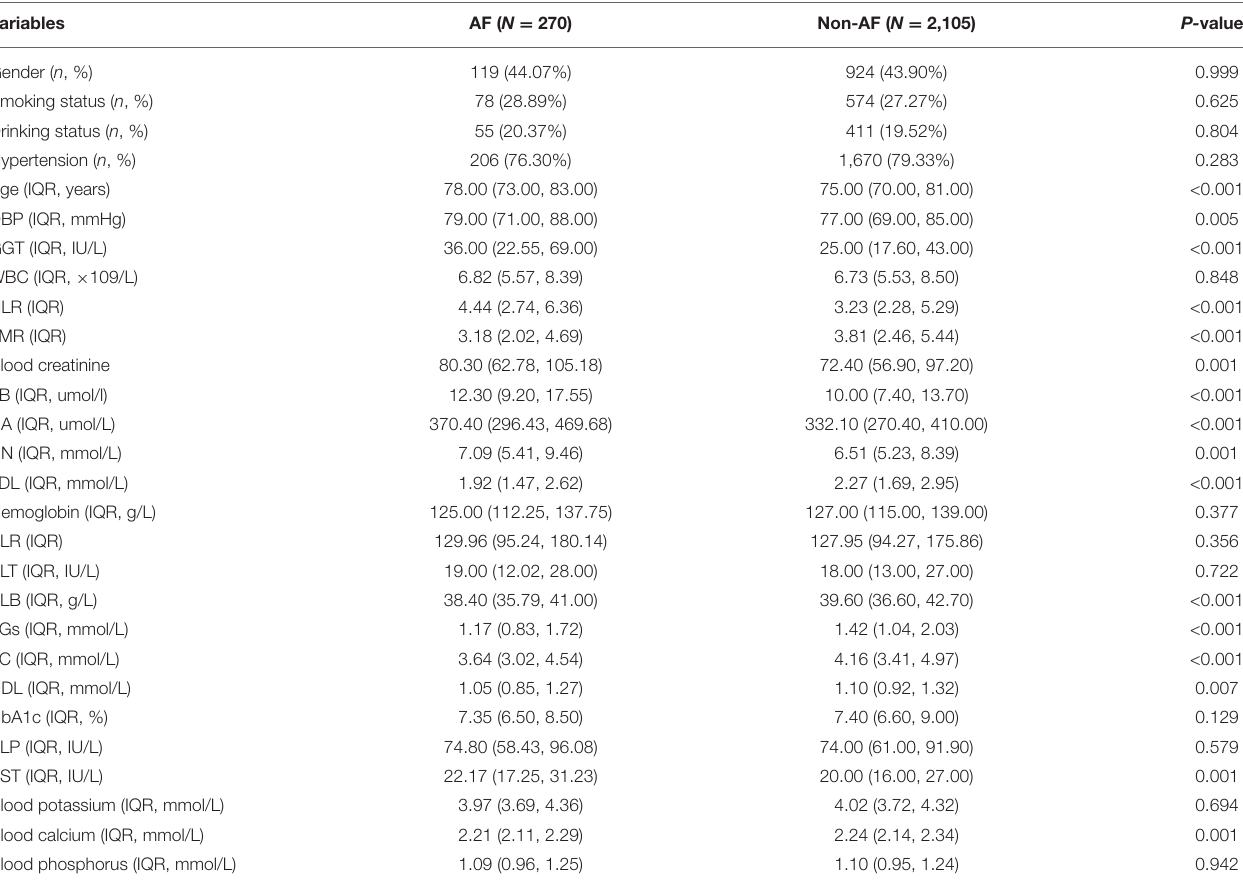
TABLE 2 | Univariate analyses of variables associated with